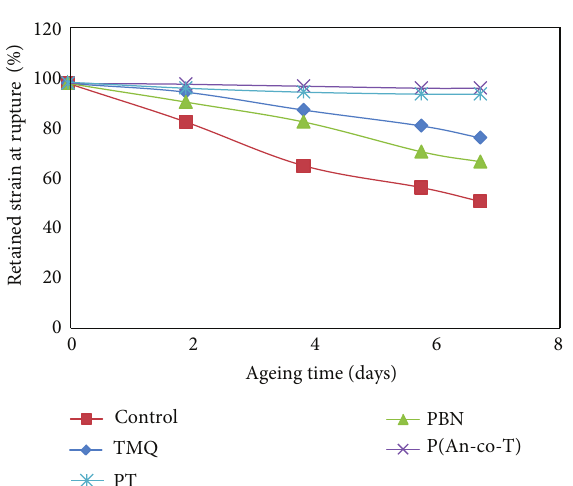
Figure 10: Retained strain at rupture versus ageing time for SBR